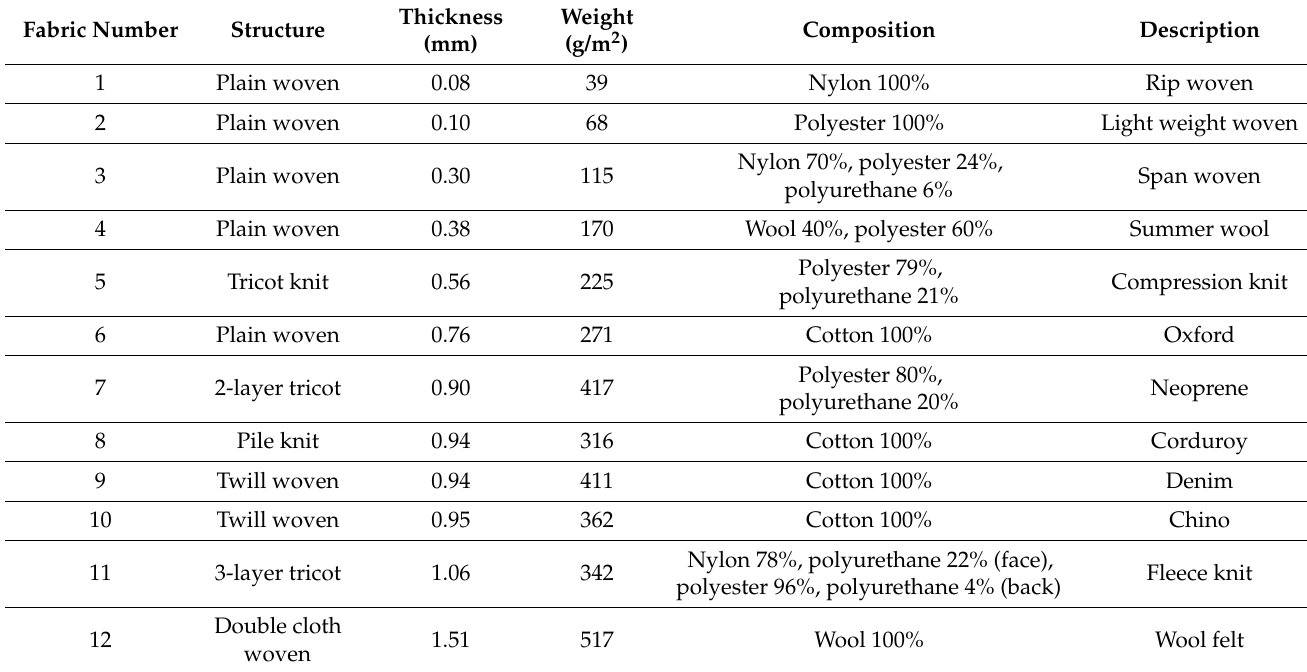
Table 1. Fabric samples for a sewing test.